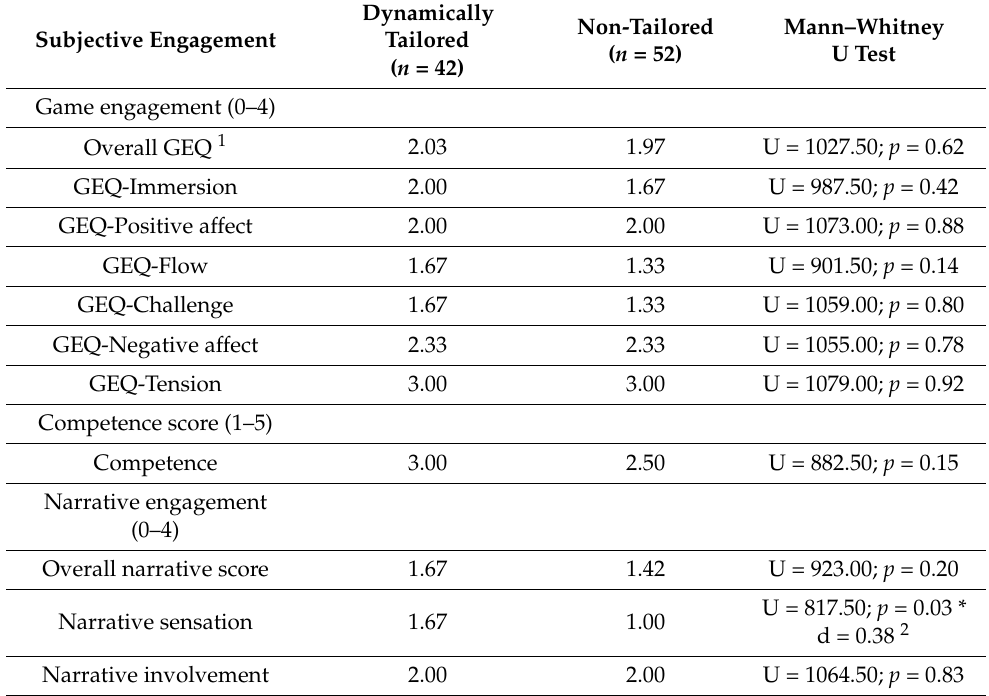
Table 3. Subjective user